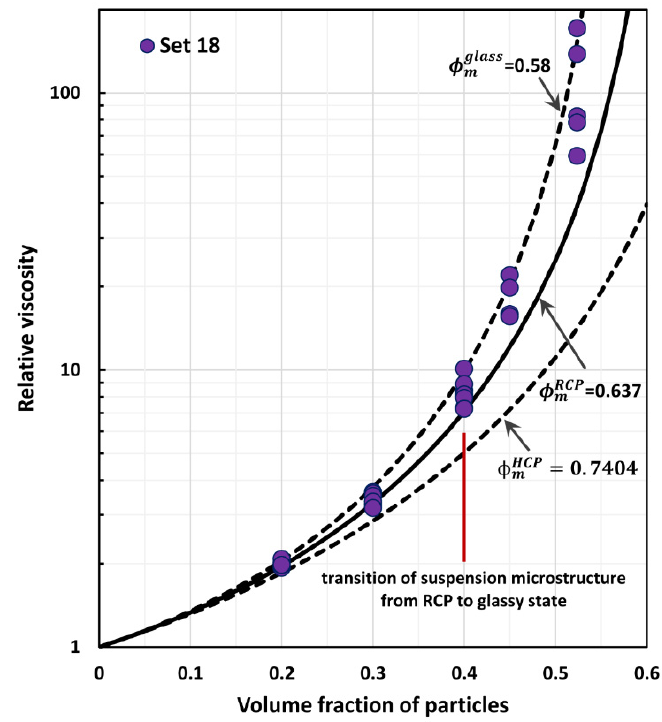
Figure 16. Transition in suspension microstructure from randomly packed clusters (RCP) to glassy clusters at a particle volume fraction of about 0.40.